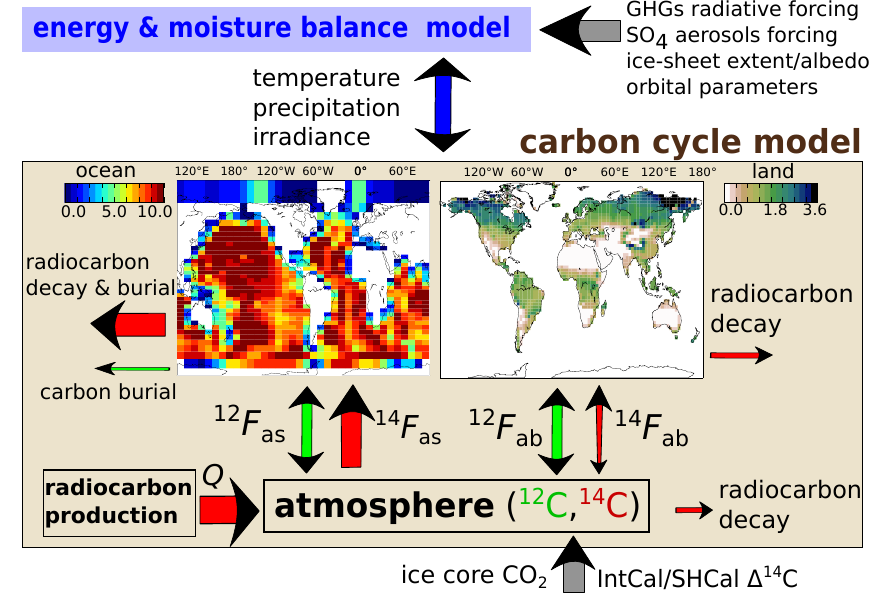
Fig. 1. Setup of the Bern3D-LPJ carbon-cycle–climate model. Grey arrows denote externally applied forcings resulting from variations in greenhouse gas concentrations and aerosol loading, orbital parameters, ice sheet extent, sea level and atmospheric CO 2 and 1 14 C. The atmospheric energy and moisture balance model (blue box and arrows) communicates interactively the calculated temperature, precipitation and irradiance to the carbon cycle model (light brown box). The production and exchange fluxes of radiocarbon (red) and carbon (green) within the carbon cycle model are sketched by arrows, where the width of the arrows indicates the magnitude of the corresponding fluxes in a preindustrial steady state. The two maps show the depth-integrated inventories of the preindustrial 14 C content in the ocean and land modules in units of 10 3 mol 14 Cm − 2 / 14 R std